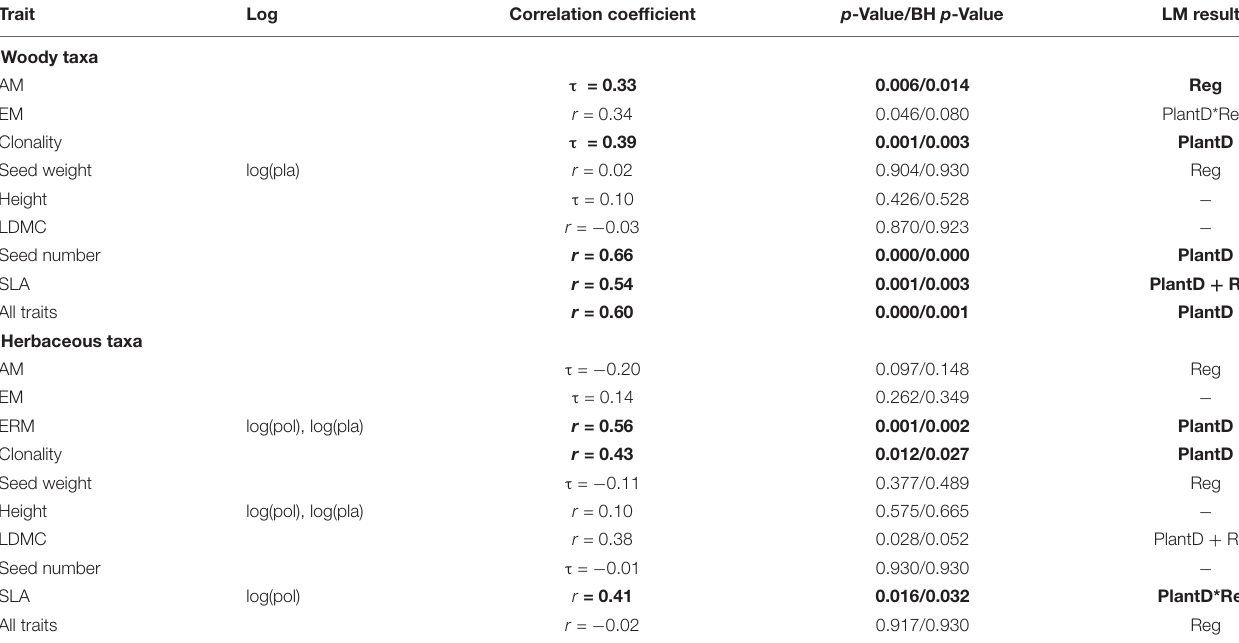
TABLE 3 | Correlation test results for pollen- and plant-based functional alpha diversity FDa estimates. Trait